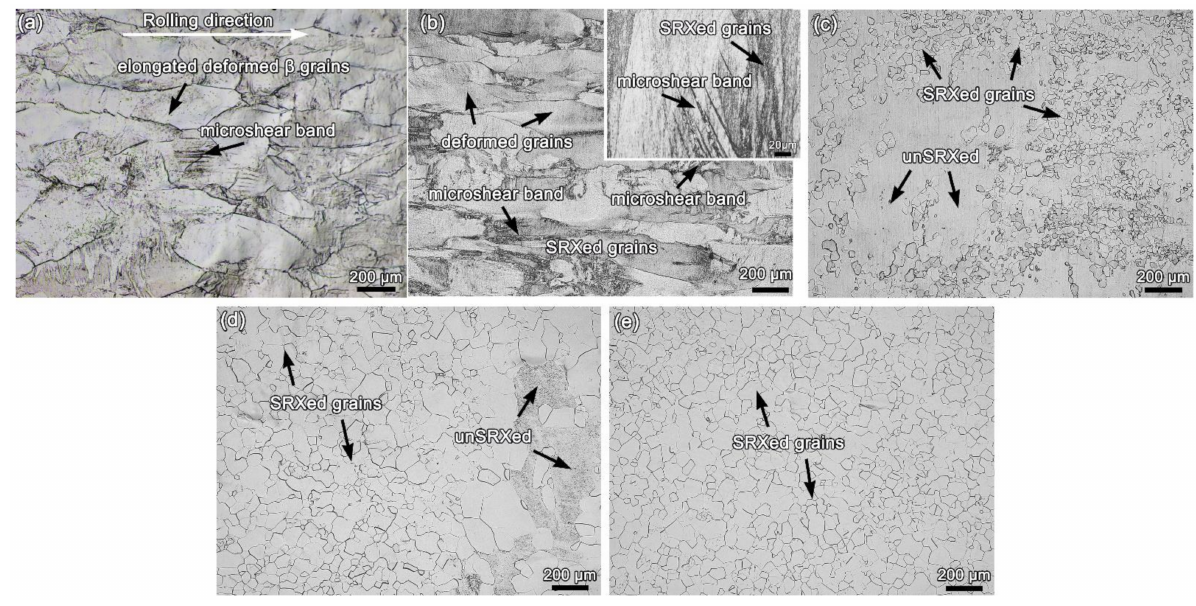
Figure 2. The OM micrographs of the alloy after different heat-treatments: ( a ) rolled microstructure; ( b ) HT-1; ( c ) HT-2; ( d ) HT-3; ( e )